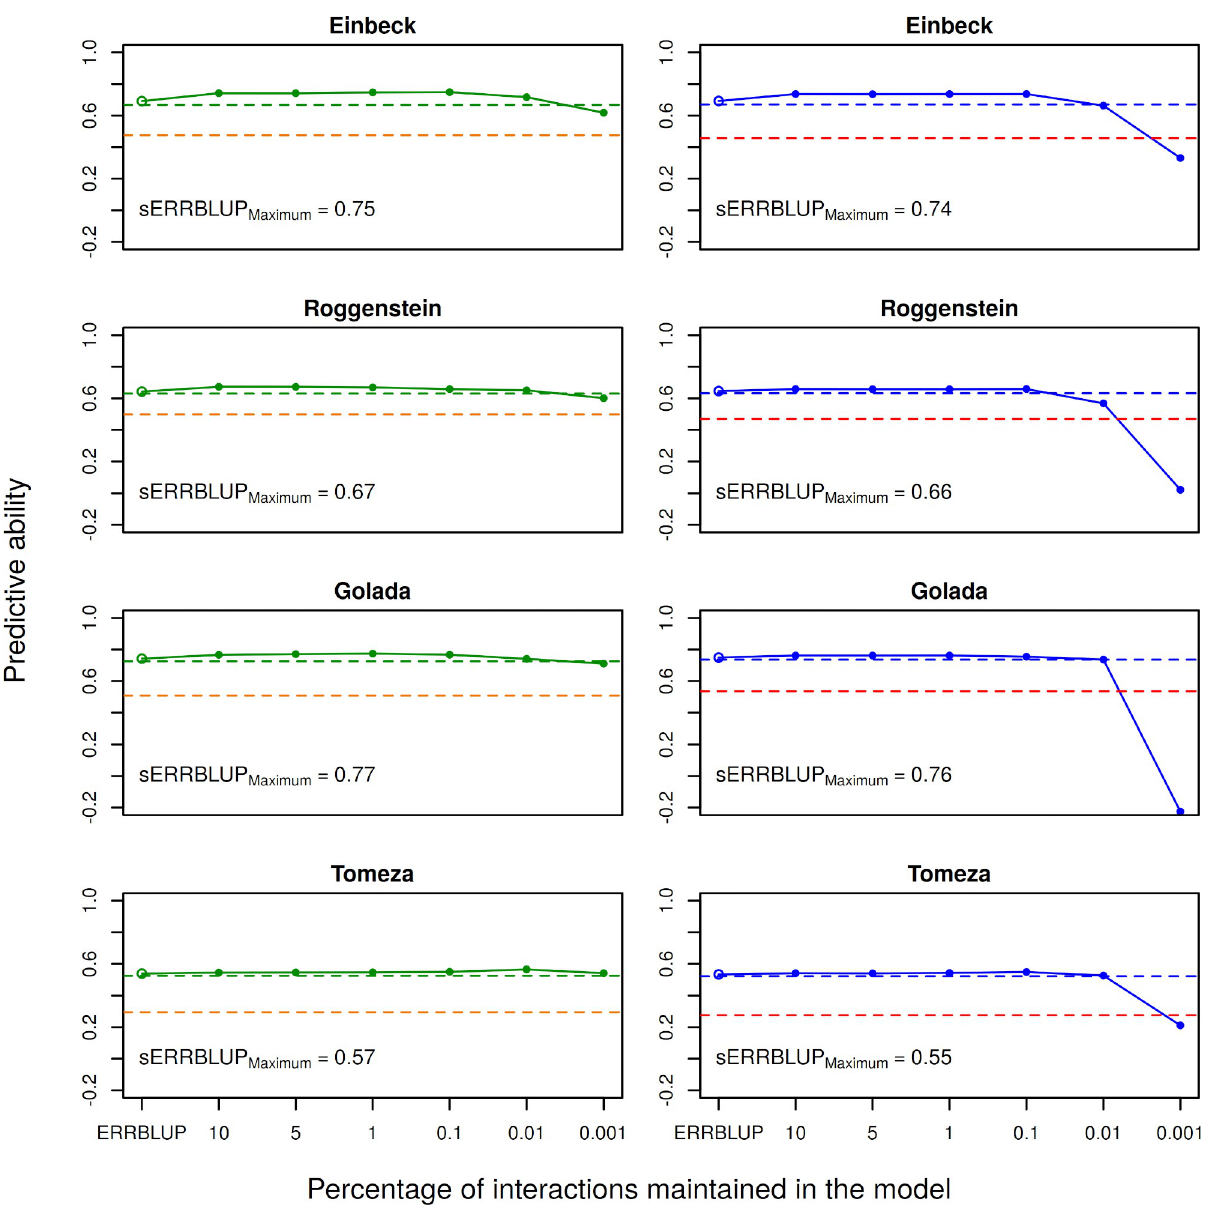
Fig 1. Predictive ability for univariate GBLUP within 2018 (orange and red dashed horizontal line), bivariate GBLUP (green and blue dashed horizontal line), bivariate ERRBLUP (open circle) and bivariate sERRBLUP (filled circles and solid line) for trait PH-V4 in Kemater based on the pruned set of SNPs (left) and haplotype blocks (right). In each plot, the sERRBLUP maximum indicates the maximum predictive ability obtained from bivariate